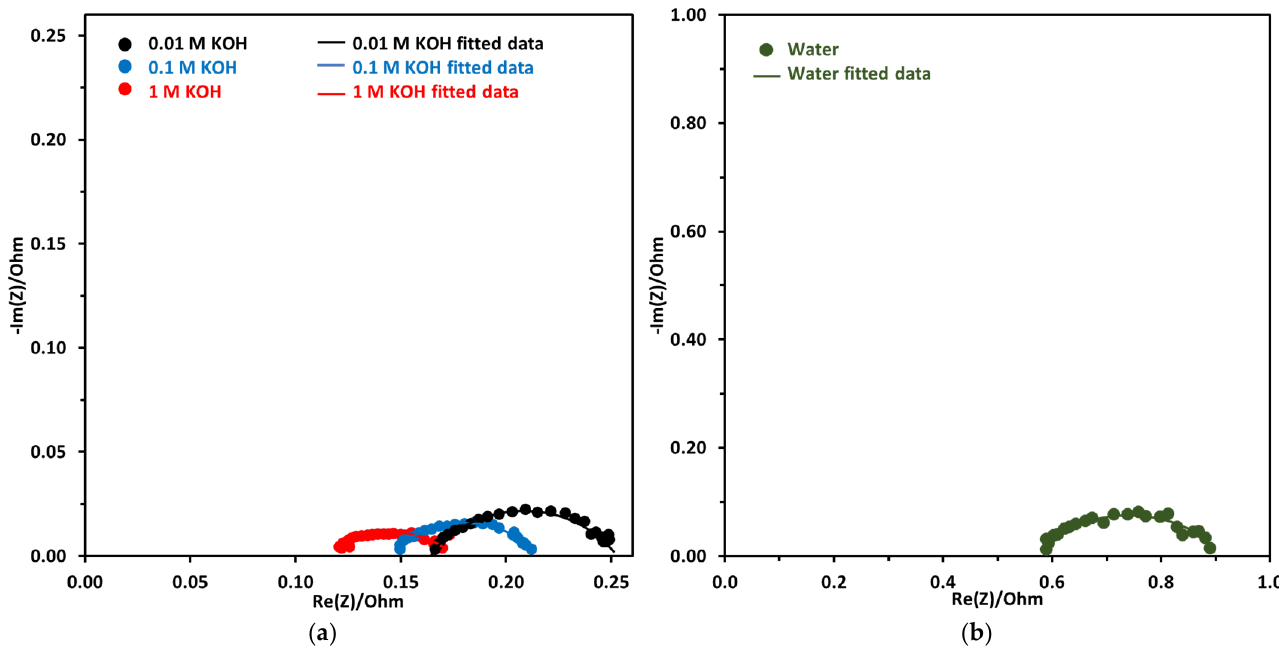
Figure 11. ( a ) Nyquist plot at a constant voltage of 2 V at 70 °C, the concentration of electrolyte was from 0.01 M to 1 M. ( b ) Nyquist plot using DI water. Pt/C was used at the cathode and NiFeCoO x was used at anode with FAA-3-50 membrane.